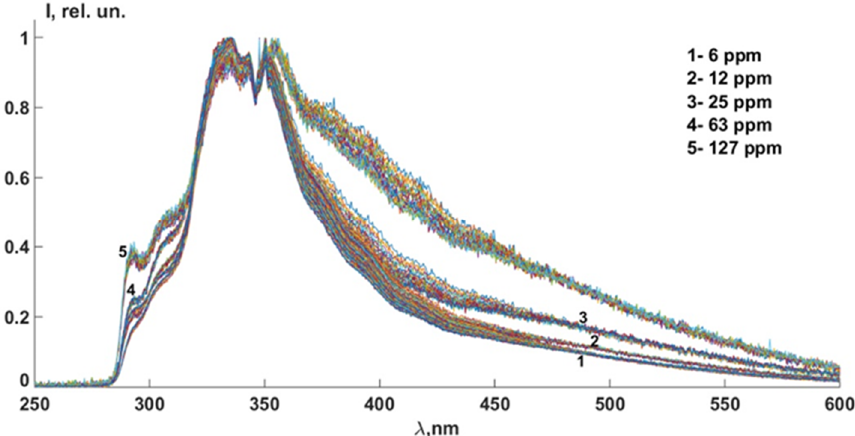
Figure 8. Sequences of the LIF spectra of the five concentrations of DMA solutions.